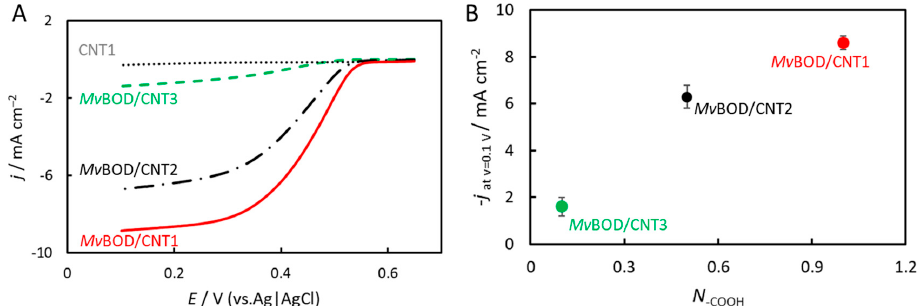
Figure 3. ( A ) Rotating disk linear scan voltammograms (LSVs) of O 2 reduction for Mv BOD/CNT1 ( solid line ), Mv BOD/CNT2 ( dashed–dotted line ), and Mv BOD/CNT3 ( broken line ). The dotted line represents an LSV on a CNT1 without enzyme. All measurements were carried out in O 2 -saturated phosphate buffer (0.1 M, pH 7.0, and 25 °C) at ω = 4000 rpm and υ = 5 mV s − 1 . ( B ) Relationships between the steady state current density and the relative amount of carboxy groups at different CNT surfaces ( N -COOH ). Reprint from [45]. Copyright (2017), with permission from Elsevier.